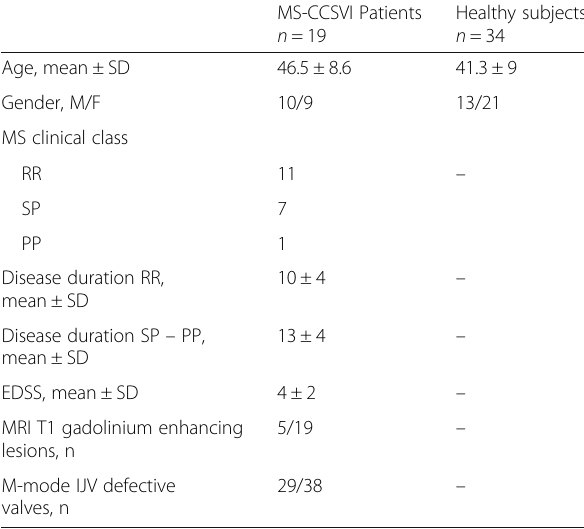
Table 1 First study population demographics